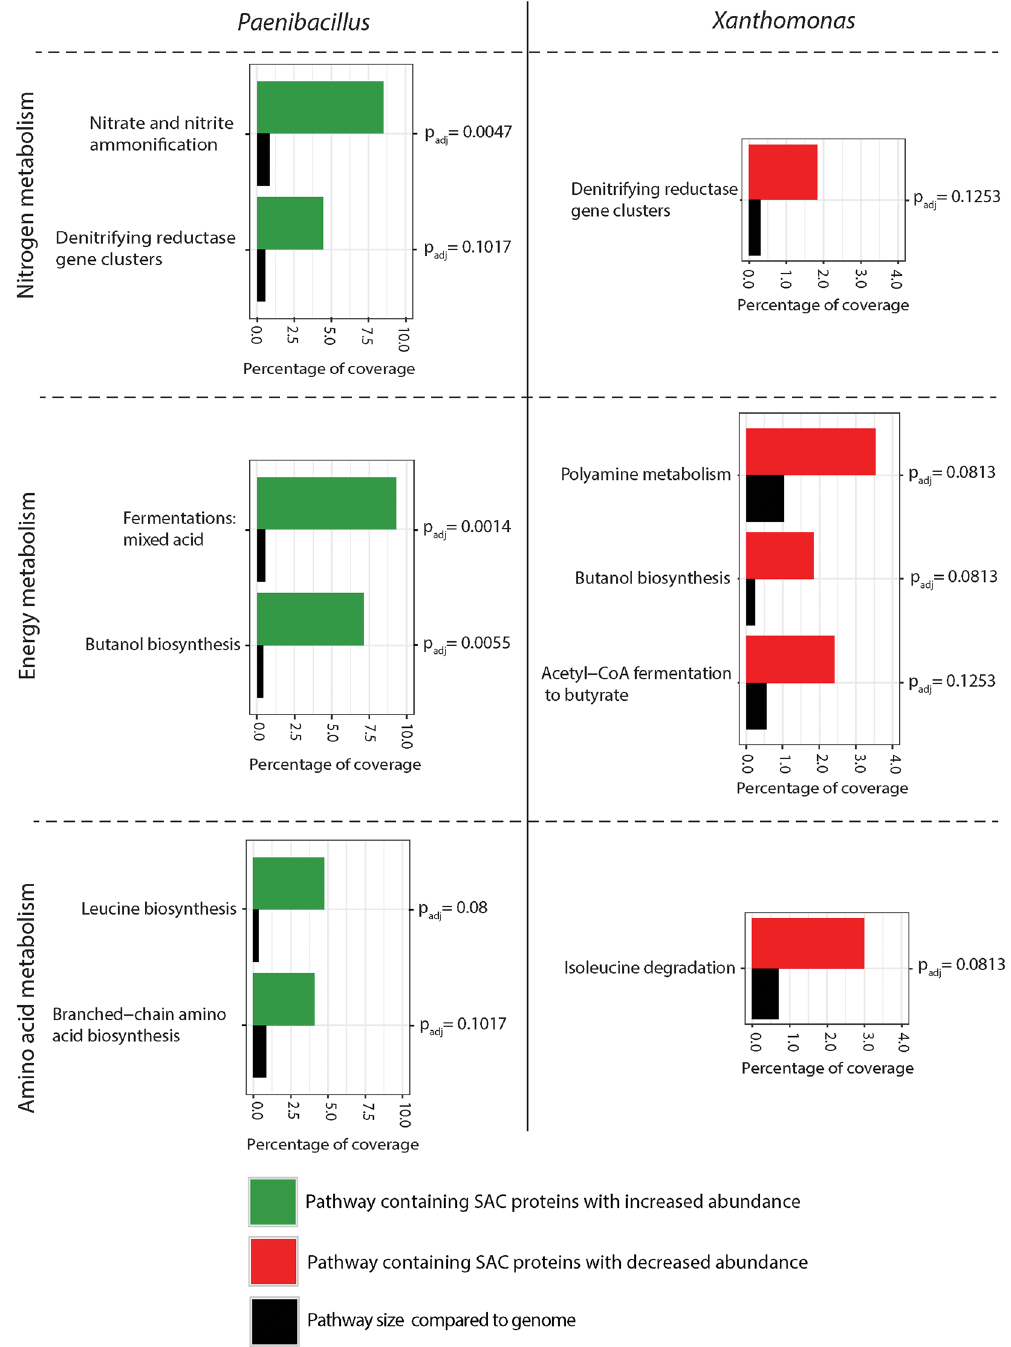
Figure 4. Pathways from Xanthomonas and Paenibacillus showing opposite trends in the four-species biofilm. SCA proteins were mapped with subsystems classifications from RAST. Pathways were analysed for regulation using a Fisher’s exact test. FDR adjusted p-values are presented for each pathway. Black bars display pathway size compared to the size of reference proteome, which can be grouped in pathways. Green and red bars display the ratio of SCA proteins in the pathway compared to the total amount of SCA proteins in pathways. Pathways in red further indicate decreased abundance in the four-species biofilm, and pathways in green indicate increased protein abundance in the four-species